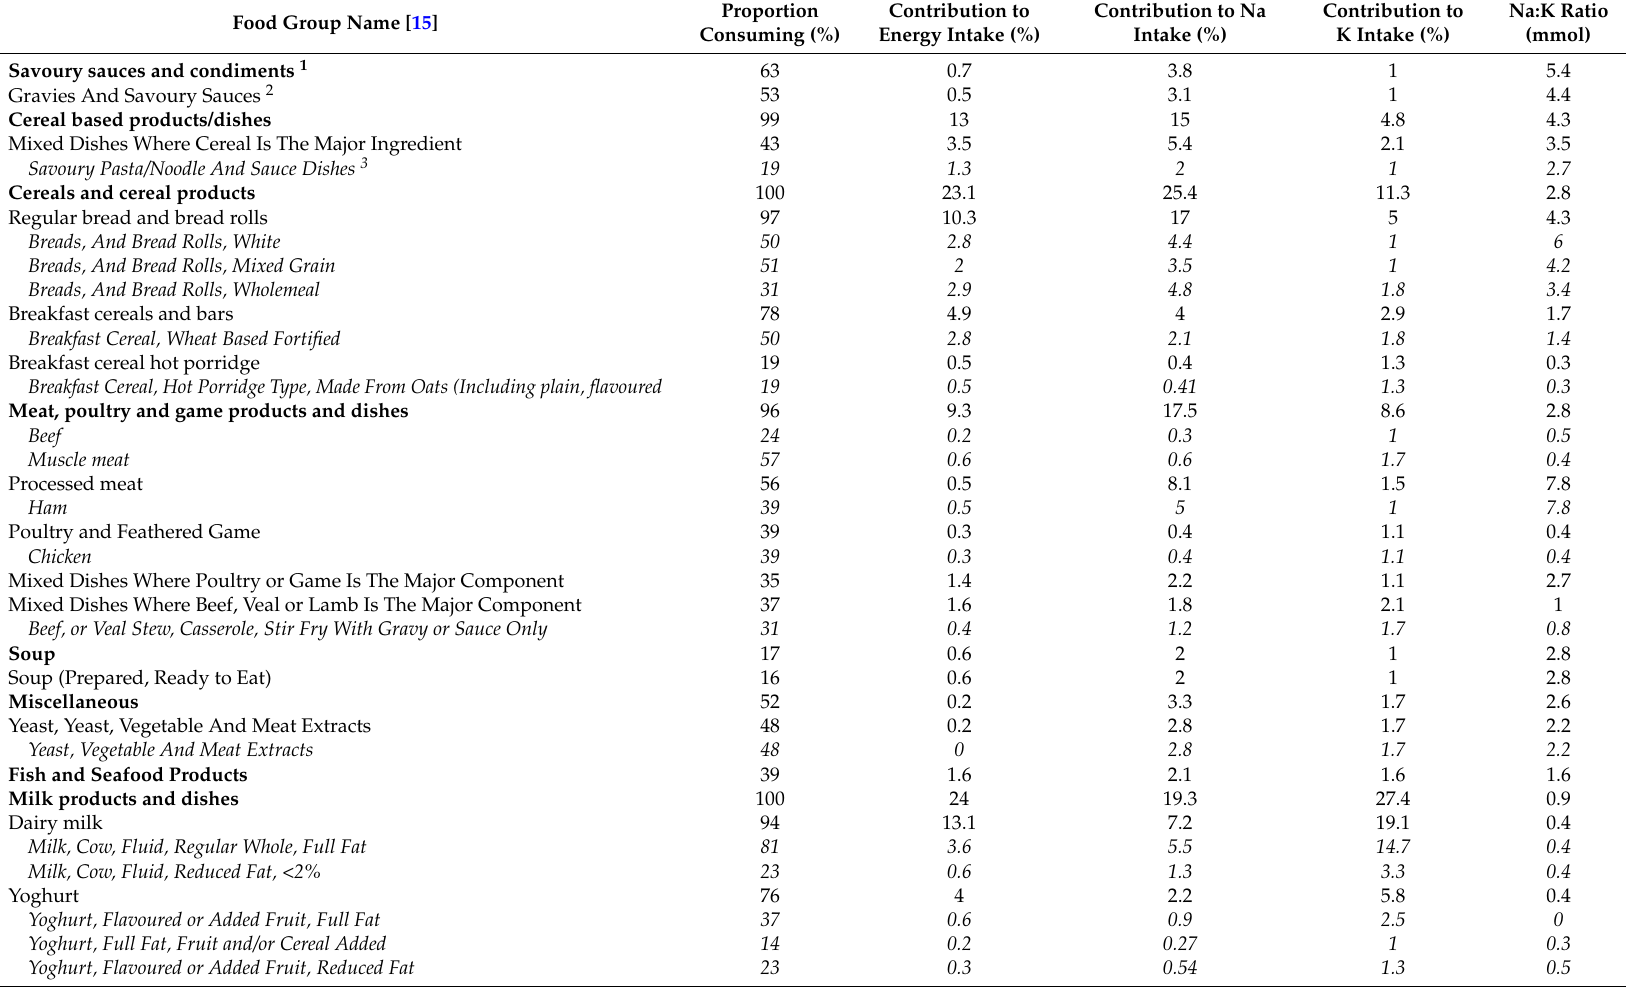
Table 3. The main food sources of sodium (Na), potassium (K), energy, and Na:K ratio from major, sub-major, and minor food categories in Australian pre-school children (food group categories that contribute >1.0% of potassium to daily intake). The Na:K ratio of major food categories is shown in descending